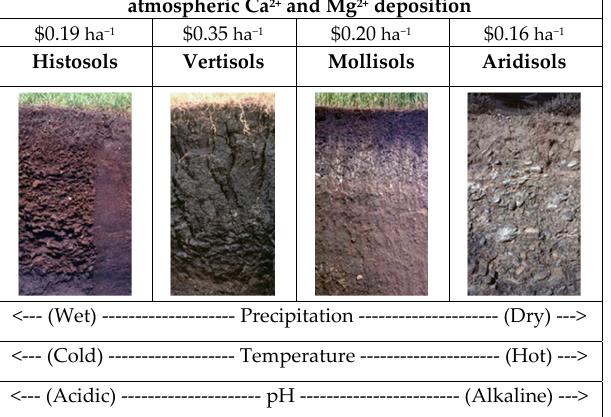
Figure 6. Expected effects (e.g., biological and physical constraints) of precipitation, temperature, and pH on average annual monetary values for four soil orders based on non-constrained potential soil inorganic carbon (SIC) sequestration from combined atmospheric Ca 2+ and Mg 2+ deposition.